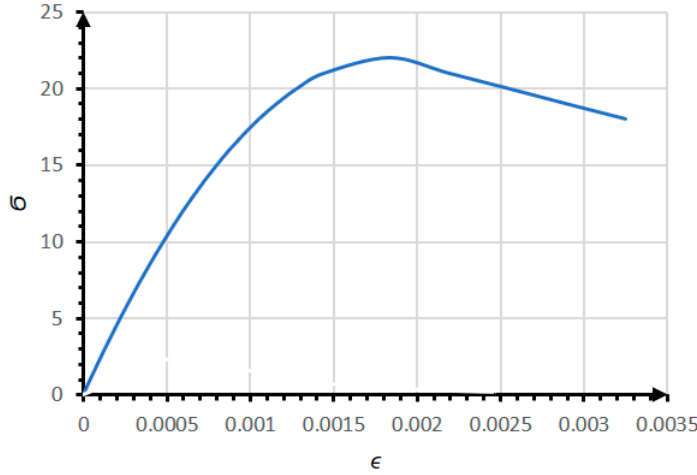
Figure 11. Stress-strain curve for compression stress in concrete.